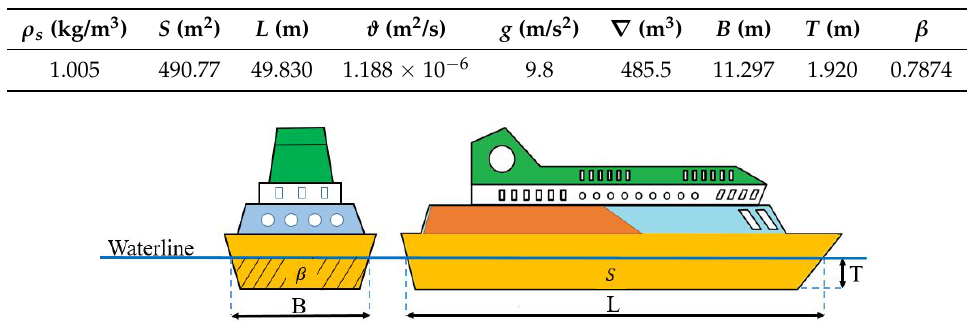
Table 1. Basic parameters of case study ship.